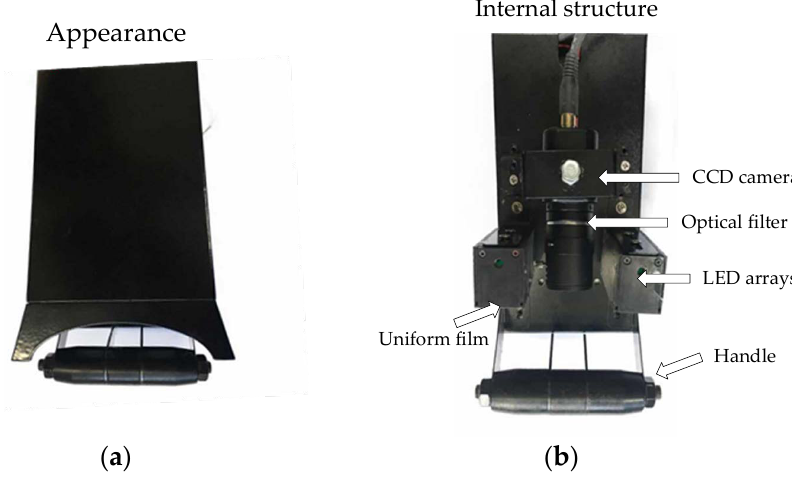
Figure 1. Image acquisition device. ( a ) Appearance; ( b ) internal structure.